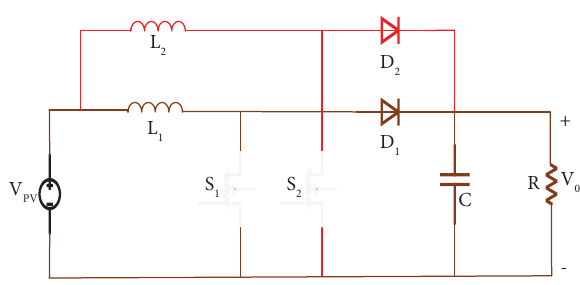
Figure 7: Mode-4: S1-OFF and